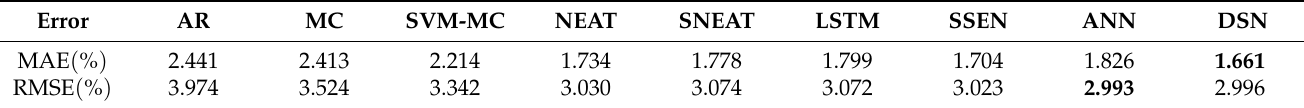
Table 1. Forecast under different models over the whole year 2010.